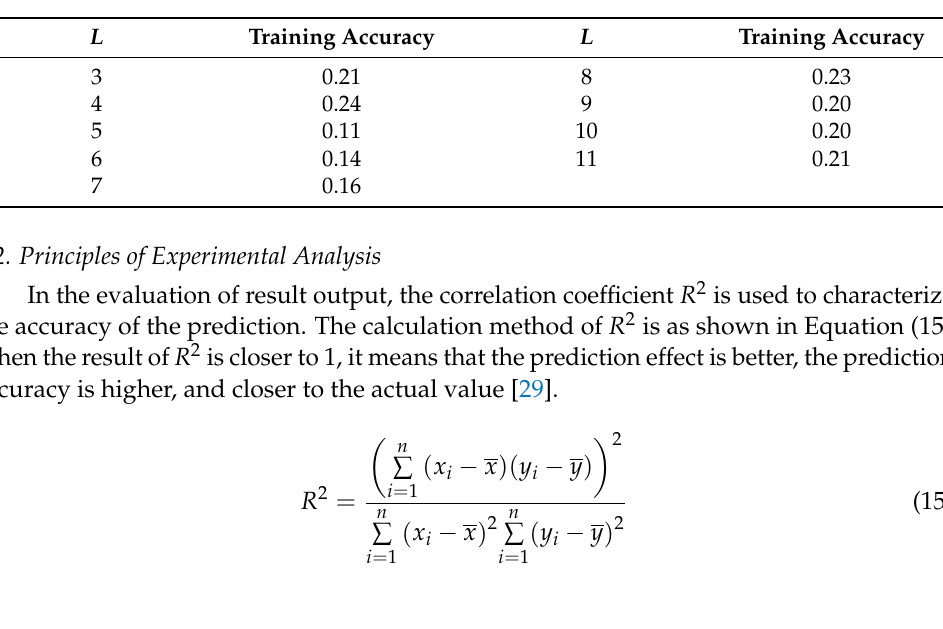
Table 4. Training accuracy under different numbers of hidden layer neurons. Figure 15. Schematic diagram of neuron parameter setting. Figure 15. Schematic diagram of neuron parameter setting.